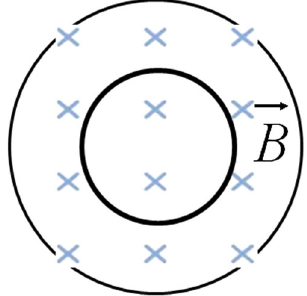
FIG. 5. The small circle represents the conducting ring inside the